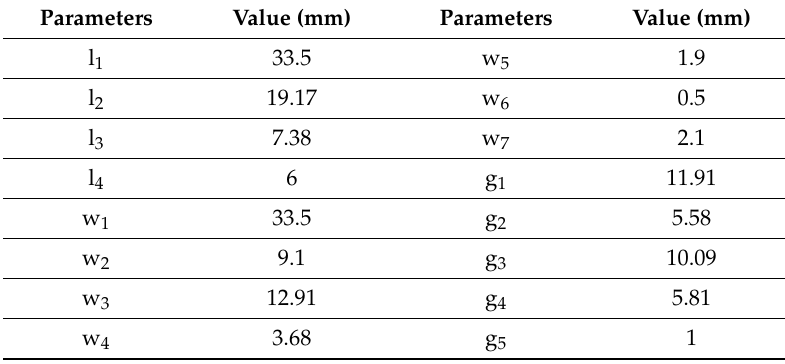
Figure 1. Schematic of the microstrip line edge-fed rectangular patch. ( a ) Top view with the stub loaded and slot etched rectangular patch; ( b ) Back view of the defected ground structure (DGS)-integrated ground plane. Table 1. Detailed Dimensions of the proposed antenna.